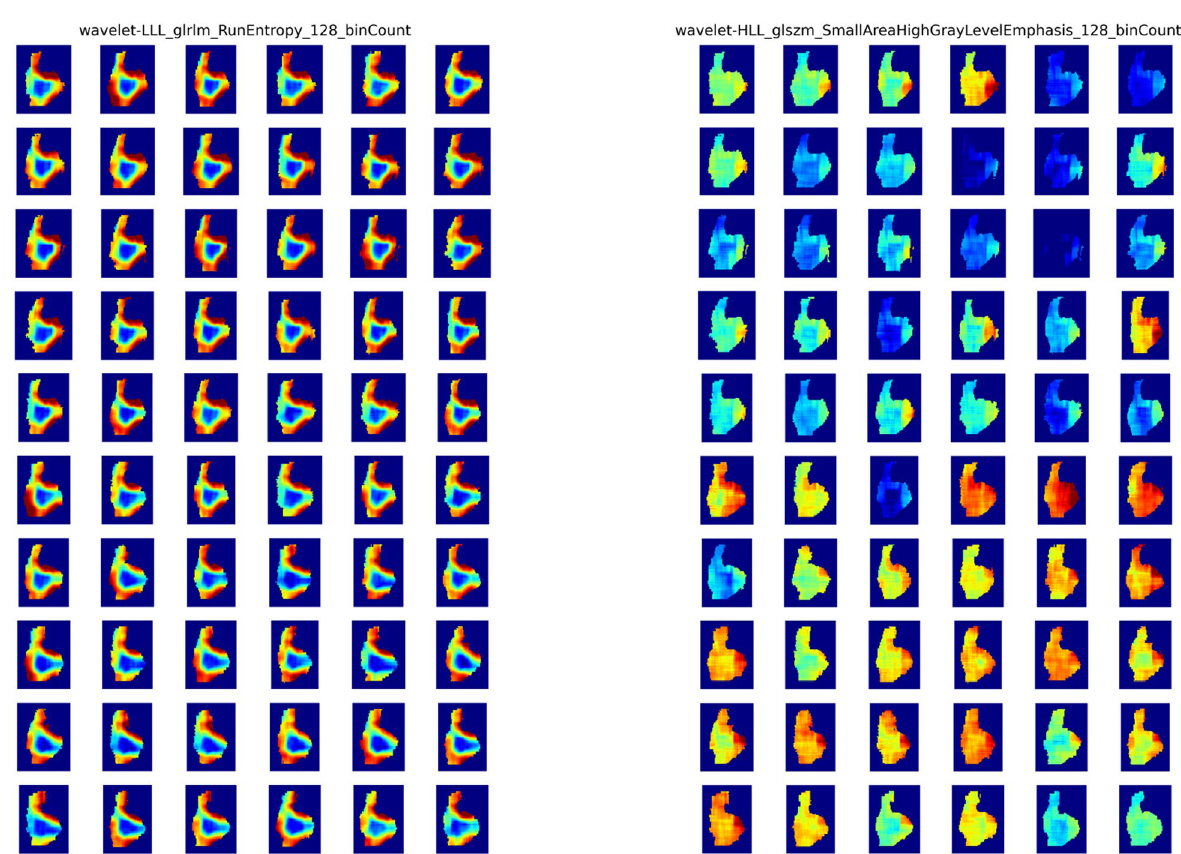
Figure 3. The feature map of wavelet-LLL_glrlm_RunEntropy (left) and wavelet-HLL_glszm_ SmallAreaHighGrayLevelEmphasis_128_binCount (right). The window is fixed between 1 and 99 percentile of the feature map to eliminate the effects of